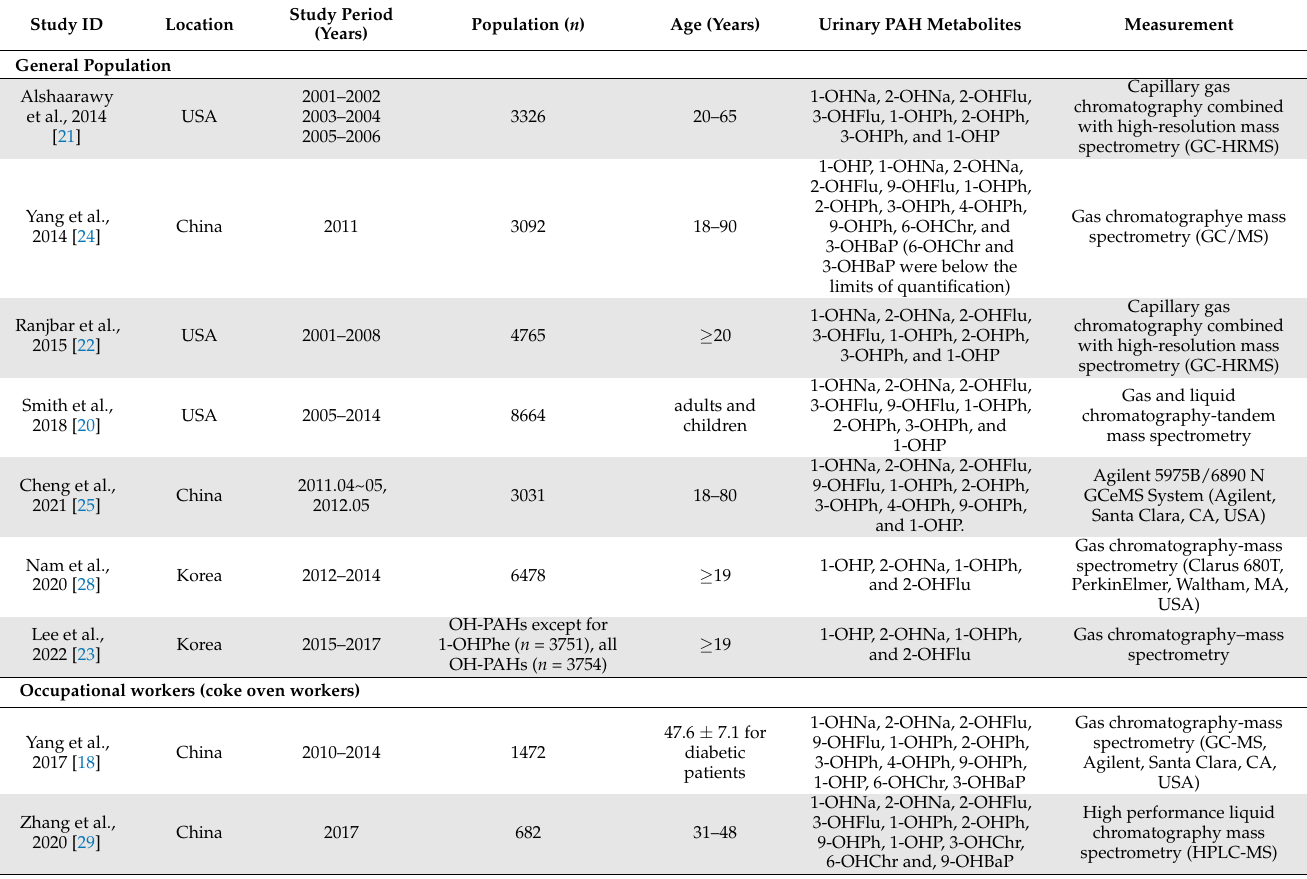
Table 1. Description of the included